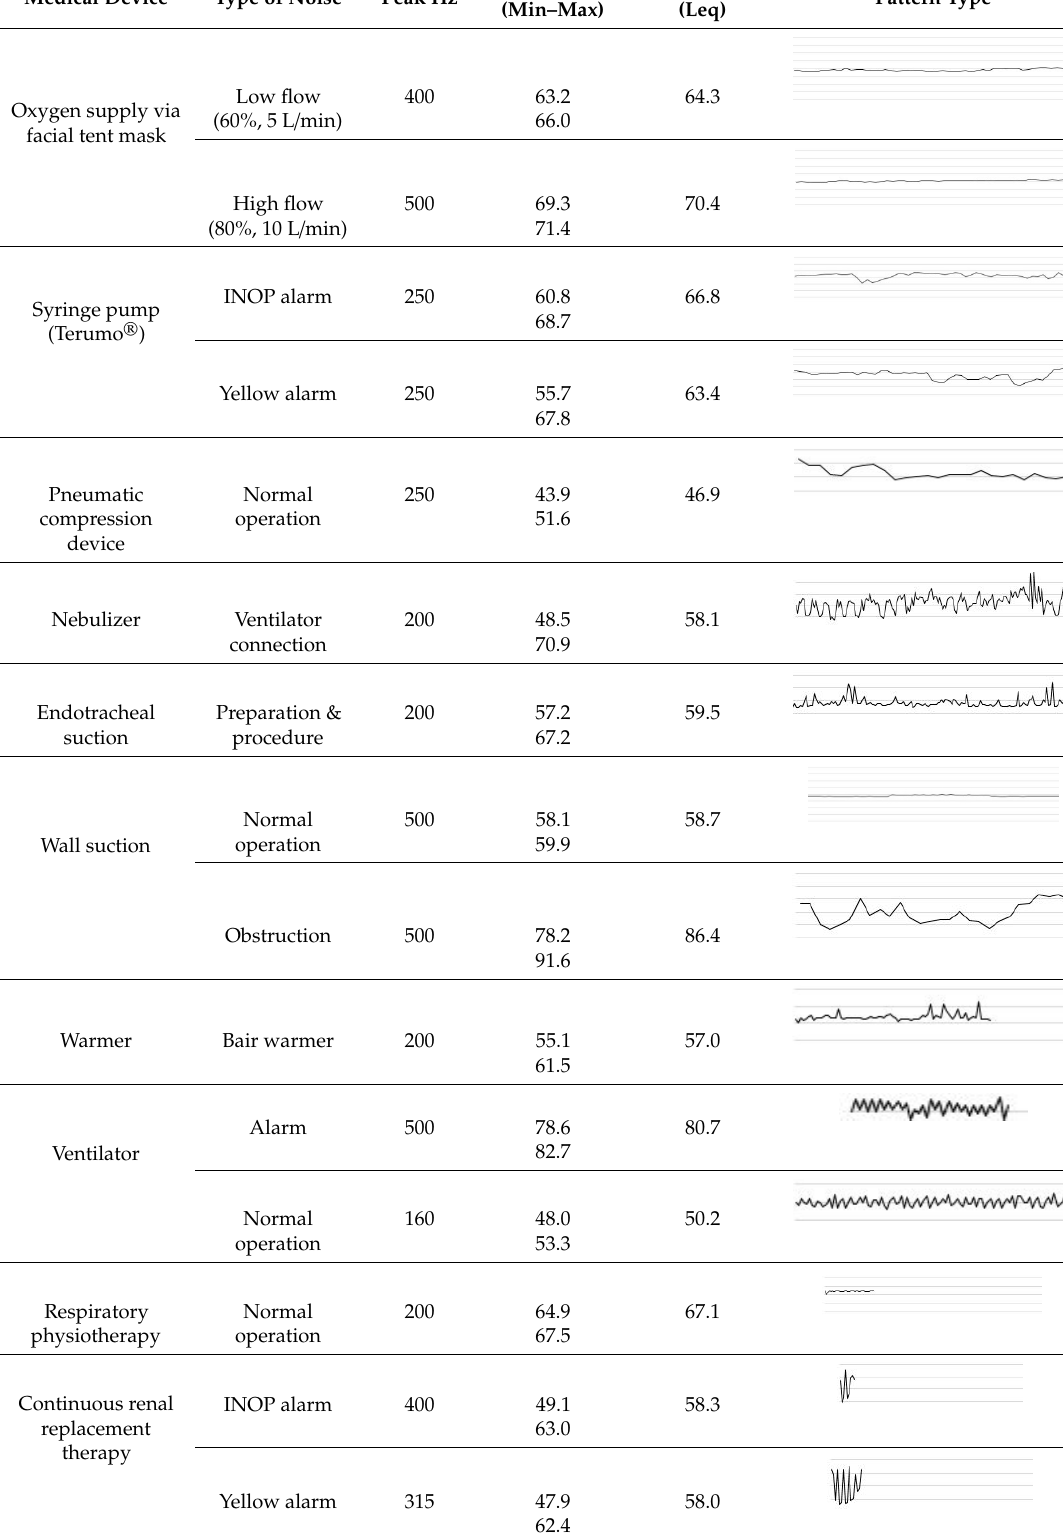
Table 3. Wave pattern analysis of noise generated by various medical devices in the ICU.